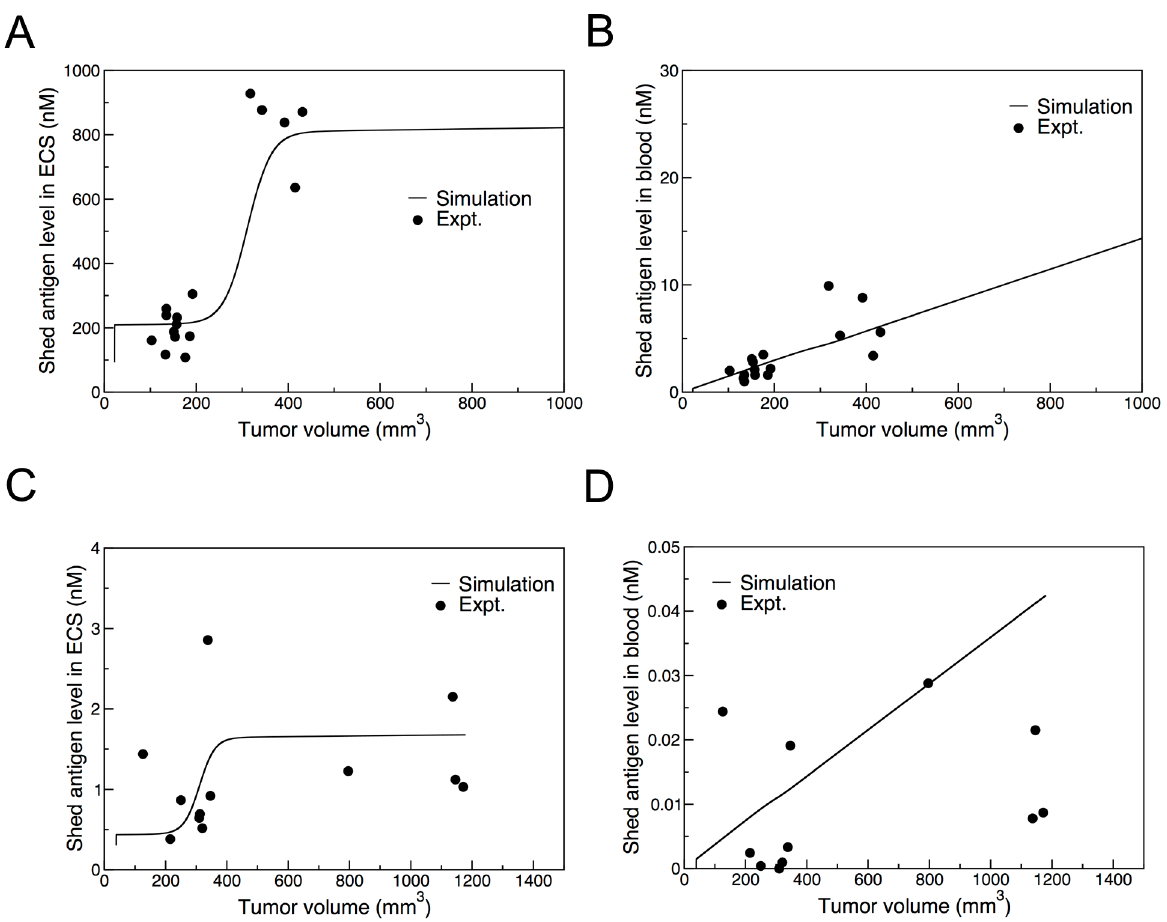
Figure 2. Tumor volume dependence of the measured (symbols) and computed (line) shed antigen levels in the extra-cellular space (A, C) and blood (B, D) for A431/H9 (A, B) and ATAC-4 cells (C, D). The experimental data for mesothelin on A431/H9 cell (panels A and B) are from Zhang et al. [7] and those for CD25 on ATAC-4 cell (panels C and D) are from Singh et al. [15].